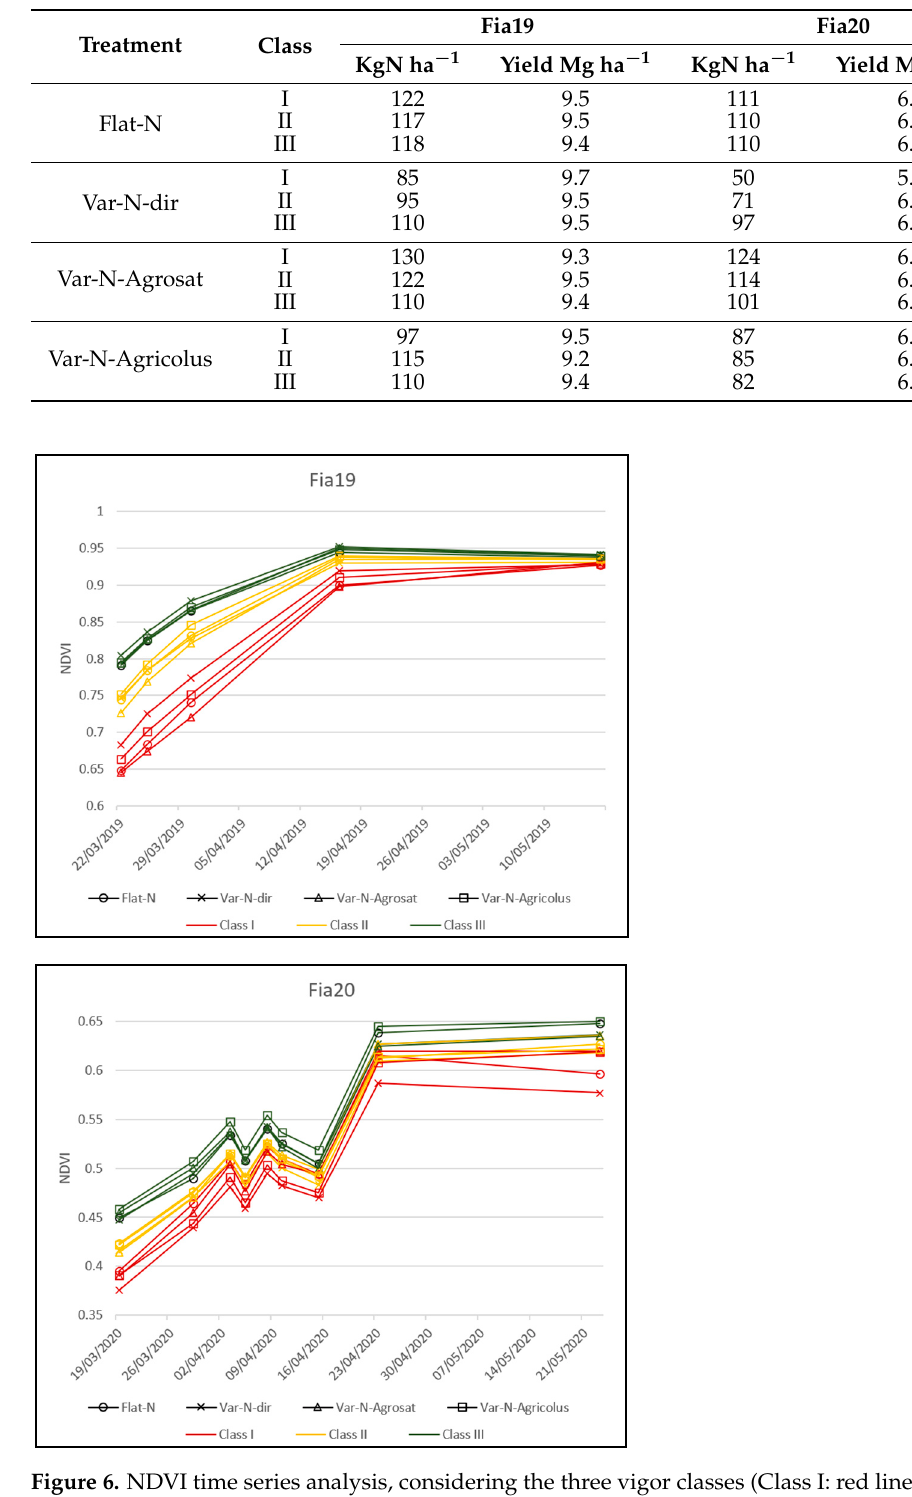
Table 7. Second N fertilization rates and grain yield, considering the three vigor classes as identified in the S2 image from 22 March 2019 for the Fia19 field, and the S2 image from 19 March 2020 for the Fia20 field.